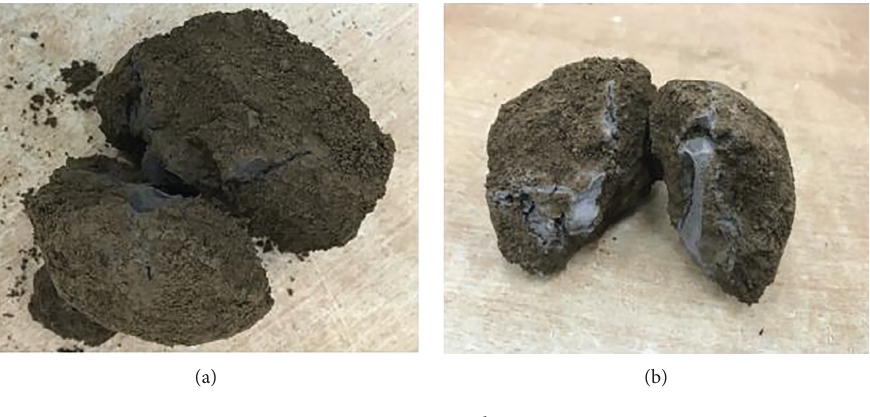
Figure 5: Vertical